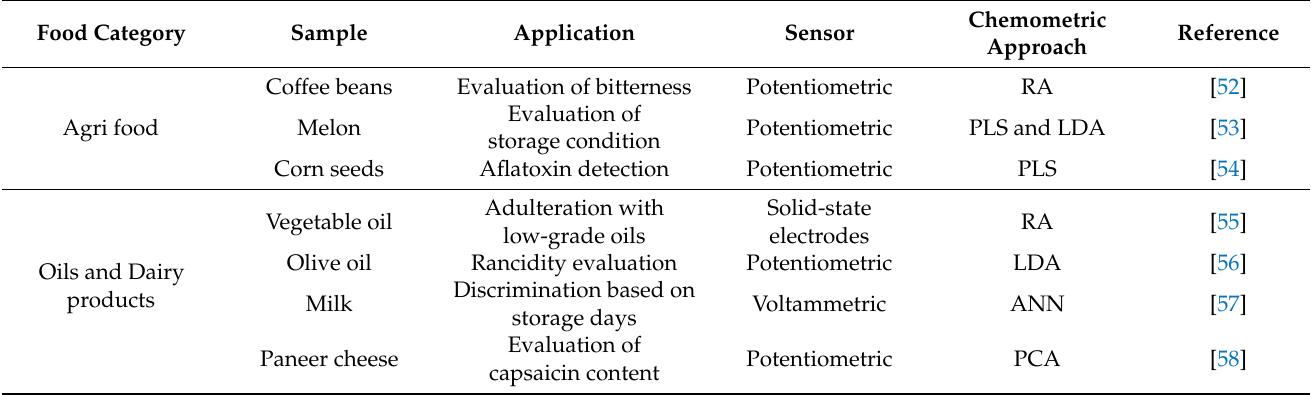
Table 2. Examples of E-tongue application for Food Analysis. ANN: artificial neural network; CDA: Critical discourse analysis; CT classification and regression tree; ELM: extreme learning machine; HCA: hierarchical cluster analysis; LDA: linear discriminant analysis; MARS: multivariate adaptive regression splines; PCA: principal component analysis; PLS: and partial least square; RA: regressive analysis; RBFNNs: radial basis function neural networks; SNV: standard normal variate; SVM: support vector